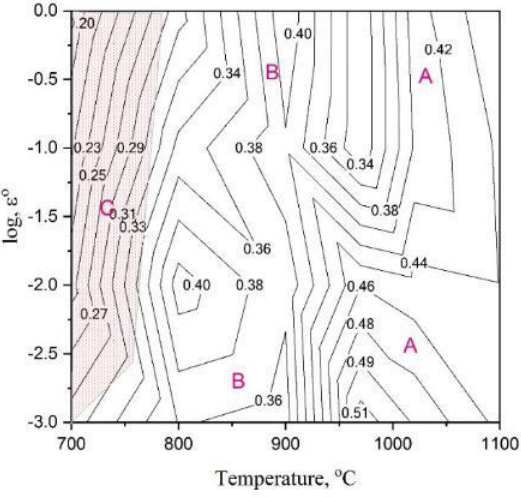
Fig.8. Derived processing map for studied alloy (applied strain =